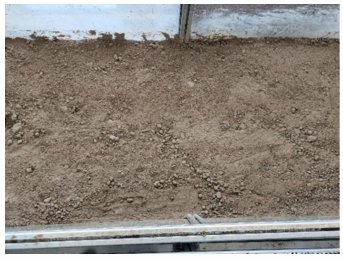
Figure 2. Initial landform.